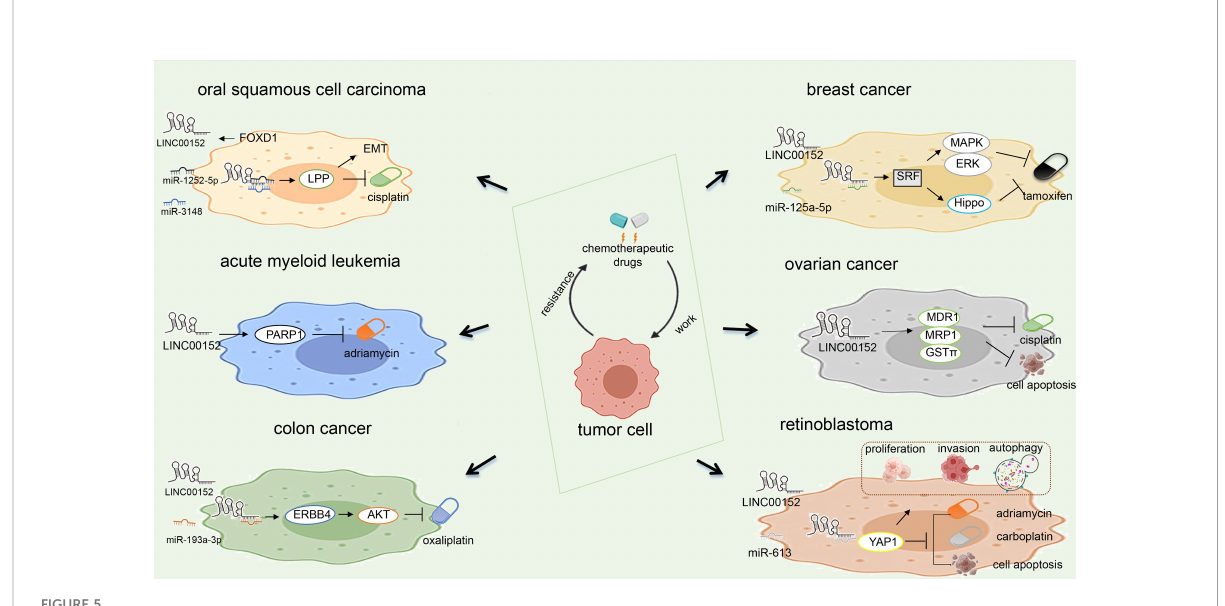
FIGURE 5 Mechanism of LINC00152 in chemotherapy